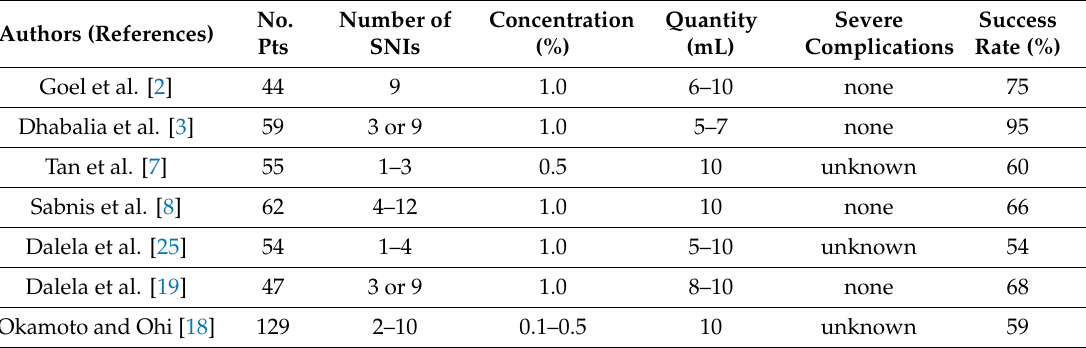
Table 3. Literature review of silver nitrate instillation for the treatment of